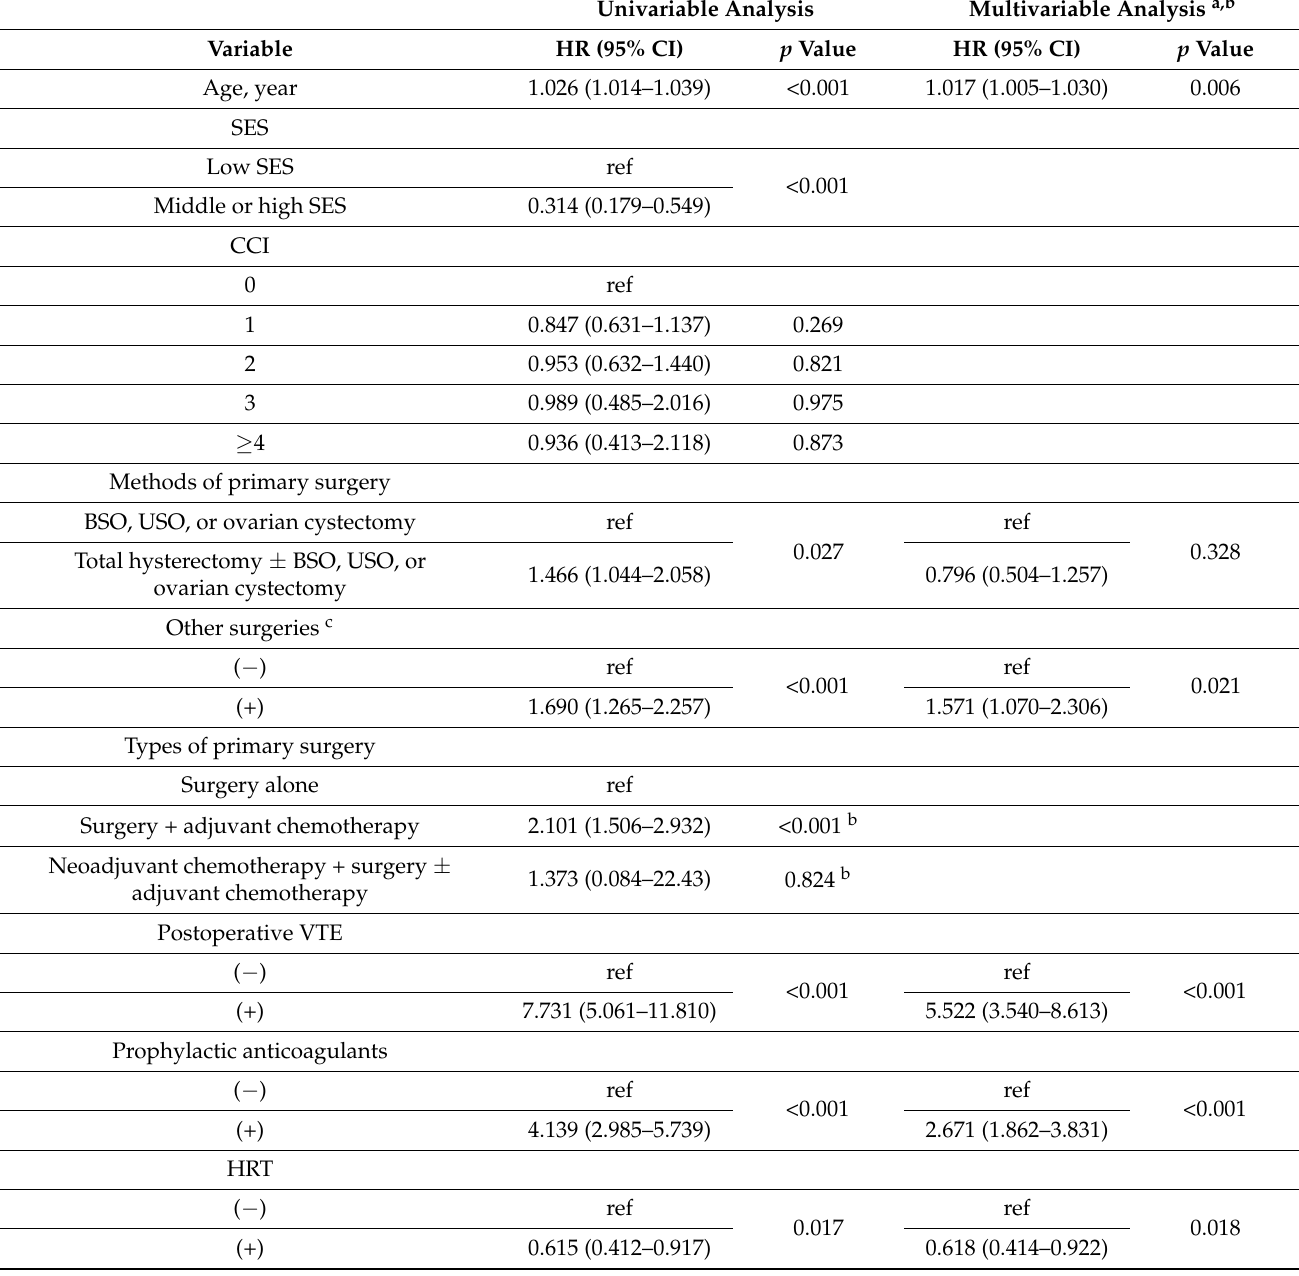
Table 2. Associations between risk factors and OS. Univariable